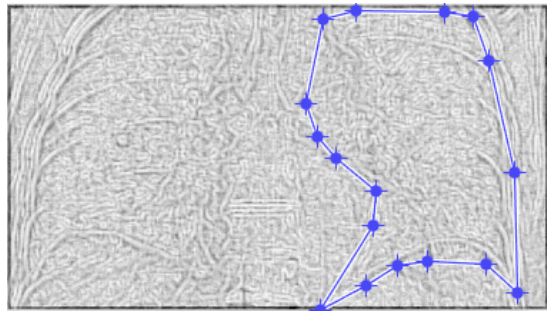
Figure 25. De fi ning the mask for the right lung of the fi fth patient. Table 5 shows the known fractal indicators, such as the fractal dimension of the CT image of the left lung, d 1L = 1.7661 ± 0.3108, and the lacunarity, Λ = 0.0310; and the fractal dimension of the right lung, d 1R = 1.7661 ± 0.3136, and the lacunarity Λ = 0.0315. Table 5. Fractal indicators for the fi fth patient . 5. AG Date 25 May 2021